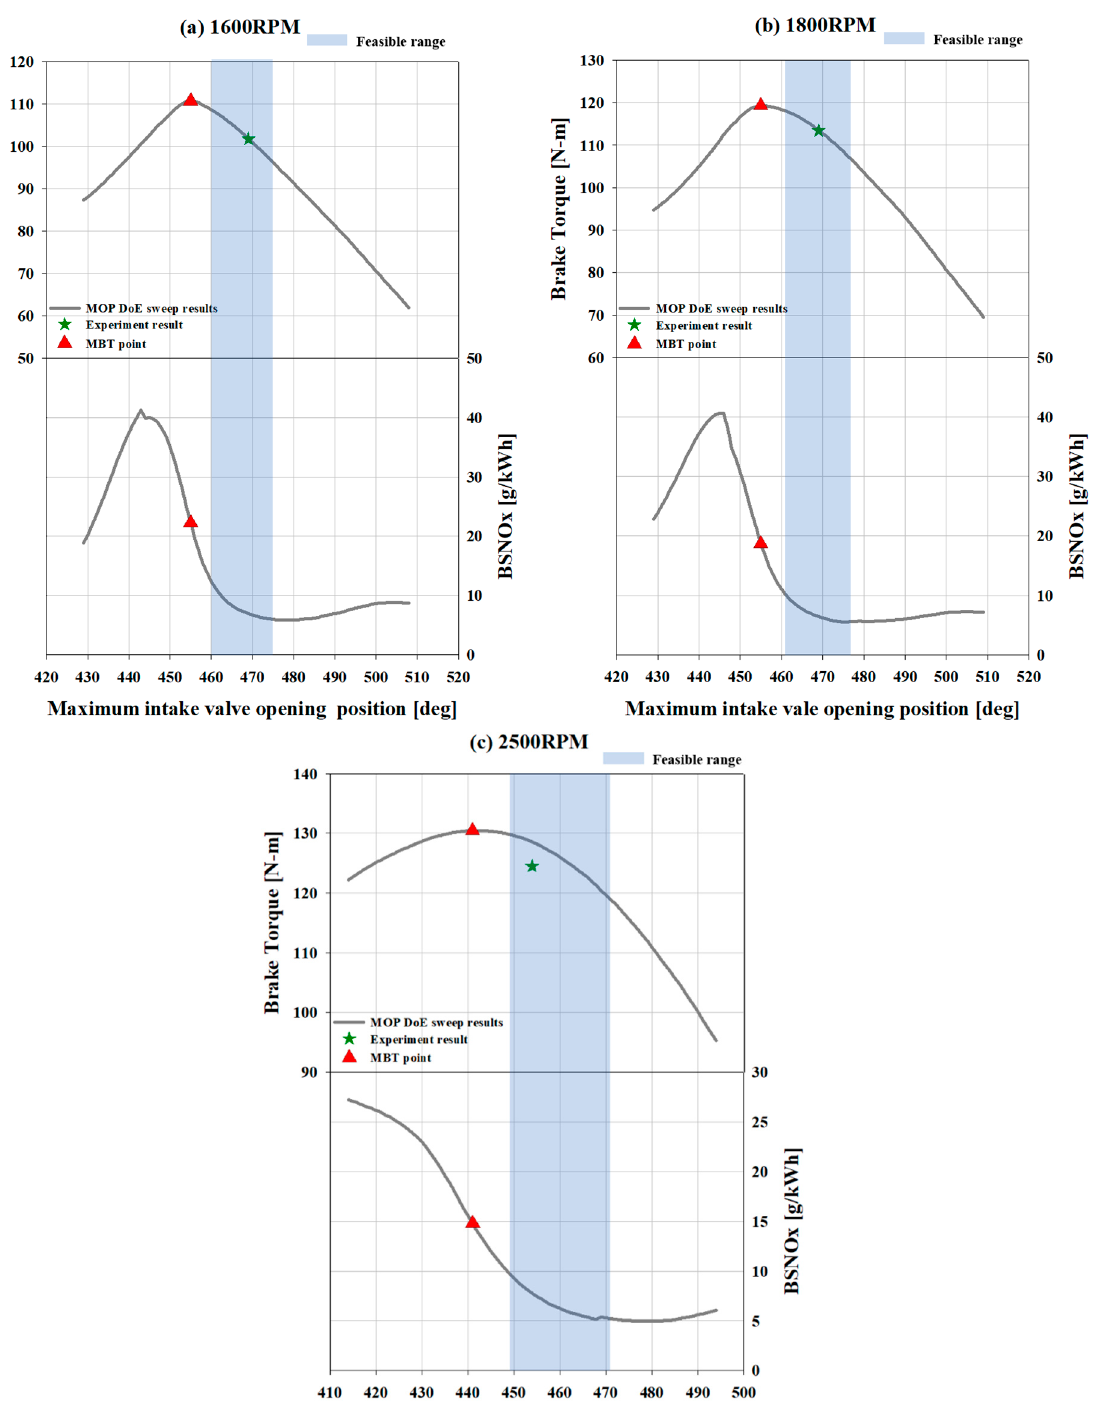
Figure 10. ( a ) Torque and NOx tendencies according to changes in IVO at 1600 RPM. ( b ) Torque and NOx tendencies according to changes in IVO at 1800 RPM. ( c ) Torque and NOx tendencies according to changes in IVO at 2500 RPM. After fixing the base conditions, valve lift, and exhaust valve closed (EVC) of the ref ‐ erence model that was used to carry out the validation, DoE proceeded by adjusting only the intake valve opening (IVO) timing. Based on the experimental value of the maximum intake valve opening position (MOP) of the selected RPM, 80 sampling results were con ‐ firmed by advancing and retarding 40° CA before and after. The results for 1600 RPM are shown in Figure 10a. DOE was performed from MOP 429° to 509° CA, and torque changes were confirmed. The torque of the reference MOP 469° CA indicated with a green asterisk is 101.7 N ‐ m, and the overlap interval is 64° CA. As a result of the DoE simulation, it was confirmed that the tendency of the sweep torque and that of the experimental values were consistent. The MBT point was identified as a reference point for selecting the valve range. The MBT point was 455° CA, which was 14° CA more advanced than the reference point, and the torque was 110.69 N ‐ m. It can be confirmed that the torque increases as the overlap section becomes wider than the refer ‐ ence, but the torque tends to decrease after the MBT point. It is judged that if the IVO timing advances more than the MBT point, combustion in the cylinder is unstable owing to the effect of the wider overlap, resulting in a decrease in torque. In the case of a non ‐ road vehicle, the responsiveness of the torque should be good, even at low speeds. There ‐ fore, the maximum overlap limit was set as 455° CA, which is the MOP of the MBT point. Based on the experimental torque, the limit of the minimum overlap was determined to be 474° CA with a torque of 96.62 N ‐ m or more, which is a 5% error range. The amount of NOx generated had a minimum value at MOP 479° CA, which is 10° CA retarded com ‐ pared to the reference value, MOP 469° CA. The overlap section is a 54° CA interval, which is 10° CA lower than the existing 64° CA, which acts as a diluent such as EGR due to the increase in the residual gas friction in the cylinder as the interval of the overlap decreases. As a result, during combustion, the temperature of the cylinder is lowered, and the NOx